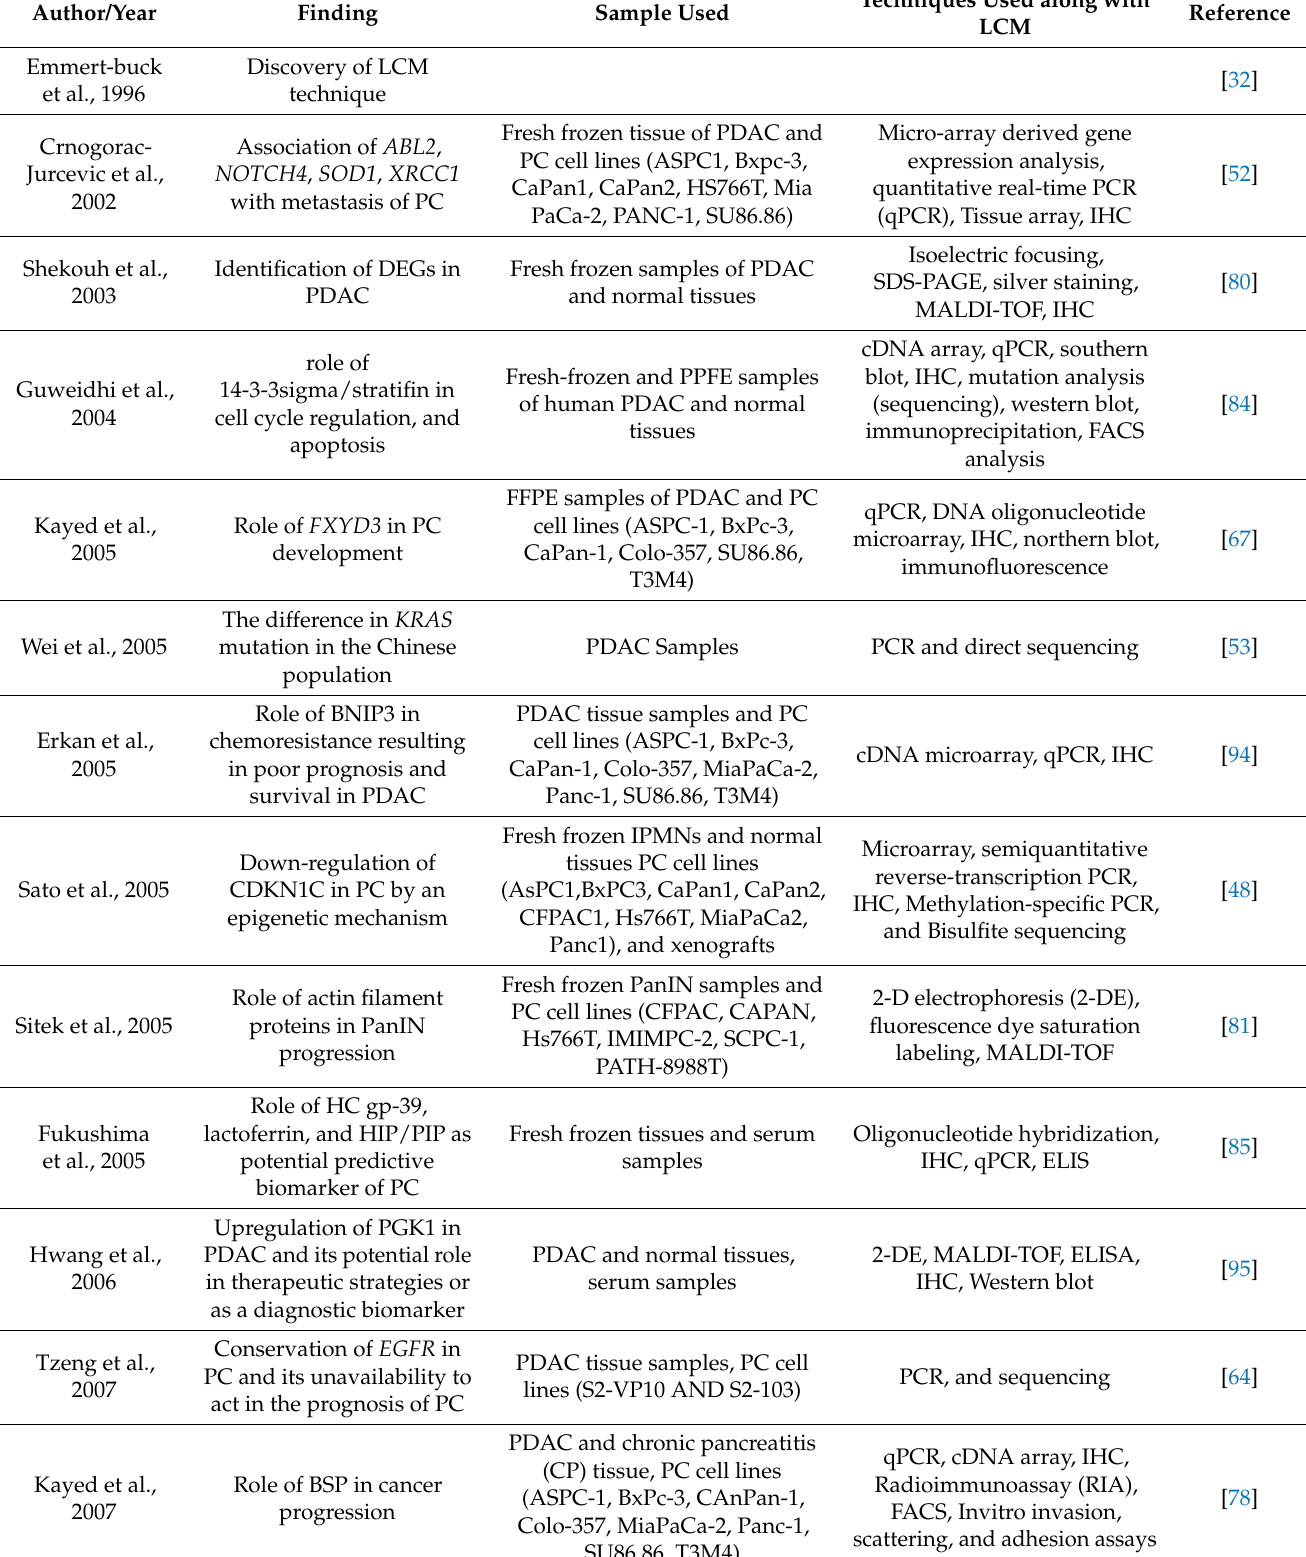
Table 1. Overview of developments in PC research using